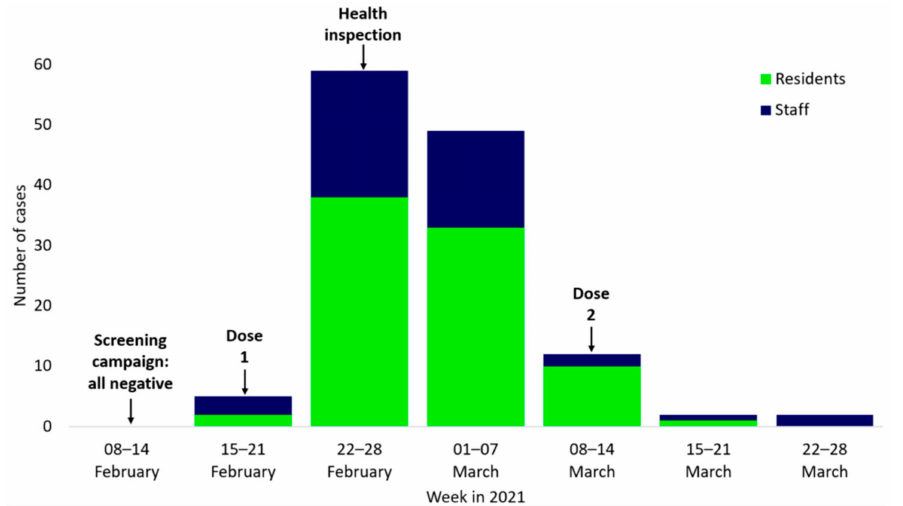
Figure 1. Number of cases between residents and staff during a long-term care facility SARS-CoV-2 outbreak in February–March 2021 in Luxembourg. Screening campaign: all negative: last screening at the LTCF with negative results only; Dose 1: First in-house vaccination campaign; Dose 2: Second in-house vaccination campaign; Health inspection: Health Directorate team visited the LTCF to assess local circumstances and